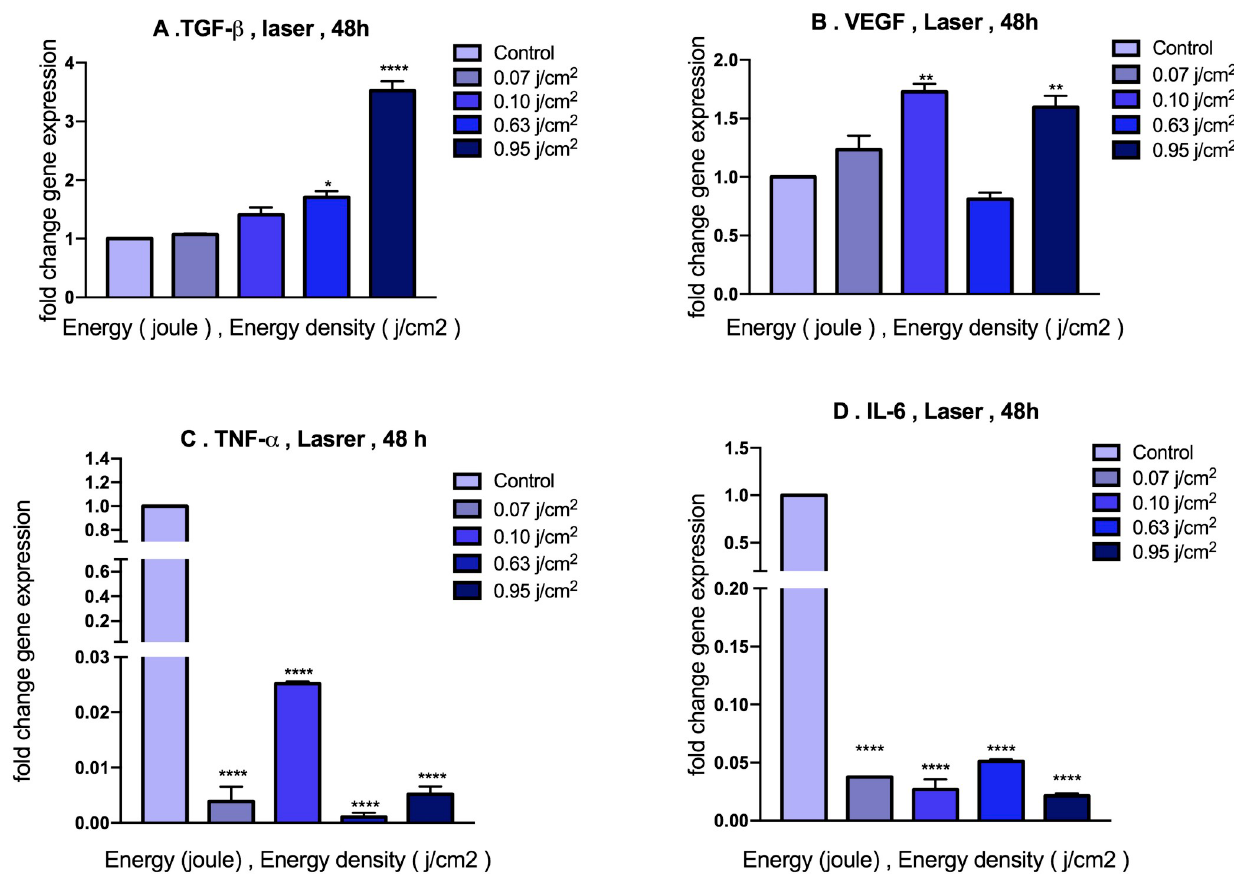
Fig 3. Alteration expression of TGF- β , VEGF, TNF- α , IL-6 in MEFs under 48h treatment with doses of 0.07, 0.10, 0.63, 0.95 j/cm 2 LLLT (450 nm). (A&B) represent a significant increase in growth factors expressions and (C&D) represent a significant multifold decrease in pro-inflammatory cytokine transcripts after 48h exposure to LLLT compared with control group. Data are represented as mean ± SEM; n = 3 ( � : p < 0.05, �� : p < 0.01, ���� : p < 0.0001).